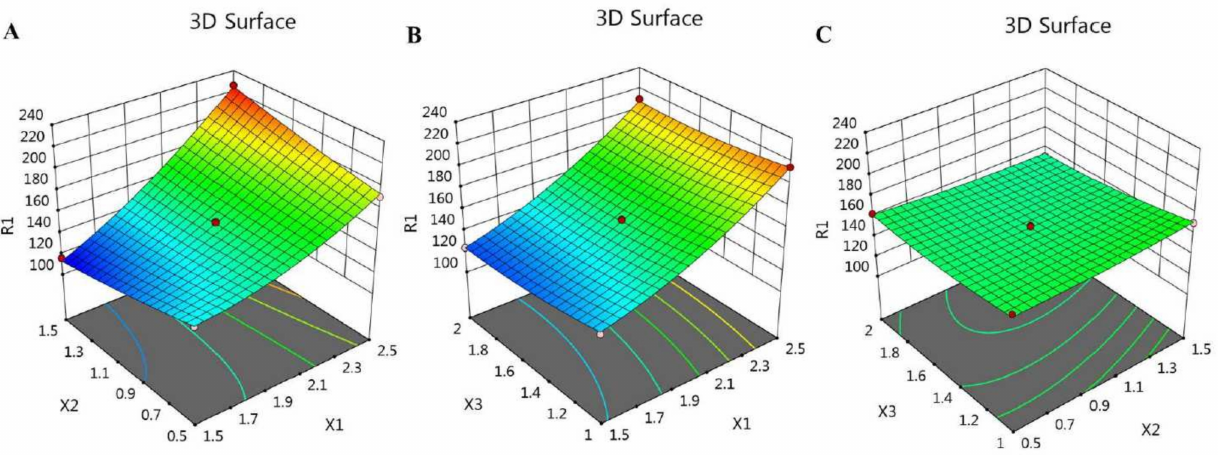
Figure 2. 3D response surface plots demonstrating the influence of the independent factors ( A ) X 1 and X 2 , ( B ) X 1 and X 3 , and ( C ) X 2 and X 3 on particle size responses (R 1